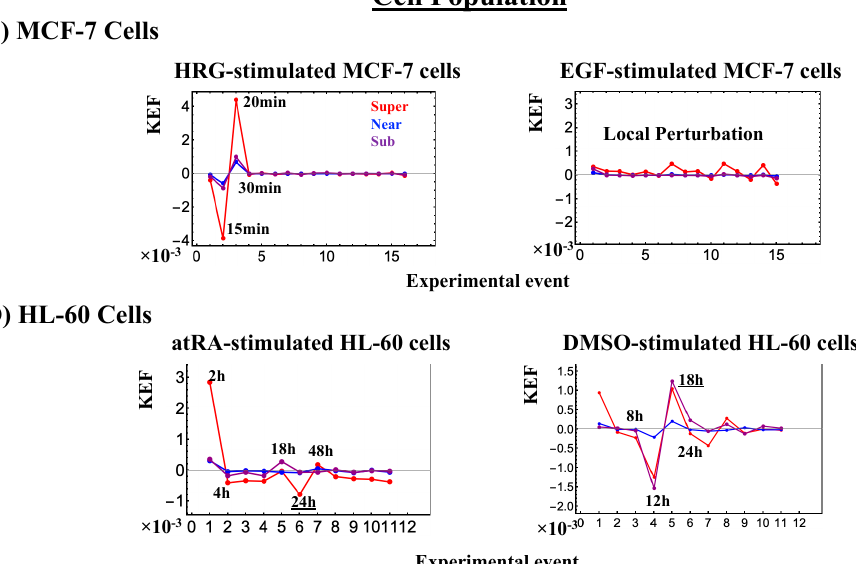
Figure 16. Kinetic energy flux (KEF). Global perturbation of the genome engine is well-manifested in the kinetic energy flux (Section 4.2.4) for single-cell responses in ( A ) embryo development and ( B ) immune cells, and population responses in ( C ) MCF-7 cells and (d) HL-60 cells. At the single-cell level, the timing of global perturbation, with the involvement of more than one critical state, coincides with that of the cell-fate change (Figures 7–9). At the population level, kinetic energy flux is damping. In HRG-stimulated MCF-7 cells ( C ), the timing of the activation of the CP (ON at 15 min; Figure 4A: left panel) is within the global perturbation (10–30 min) (intersection of interaction flux at 20–30 min: Figure 14A), whereas in EGF stimulation (right panel; no cell di ff erentiation [29]), only local perturbation occurs. On the other hand, in HL-60 cells ( D ), the timing of the perturbation of the genome engine (at 18 h, 24 h and 48 h) corresponds to the end of the damping (second-largest perturbation) for atRA-stimulated HL-60 cells (left panel) and the largest global perturbation (at 12 h, 18 h, and 24 h) for DMSO-stimulated HL-60 cells (right panel). Underlined numbers represent the timing just before the cell-fate